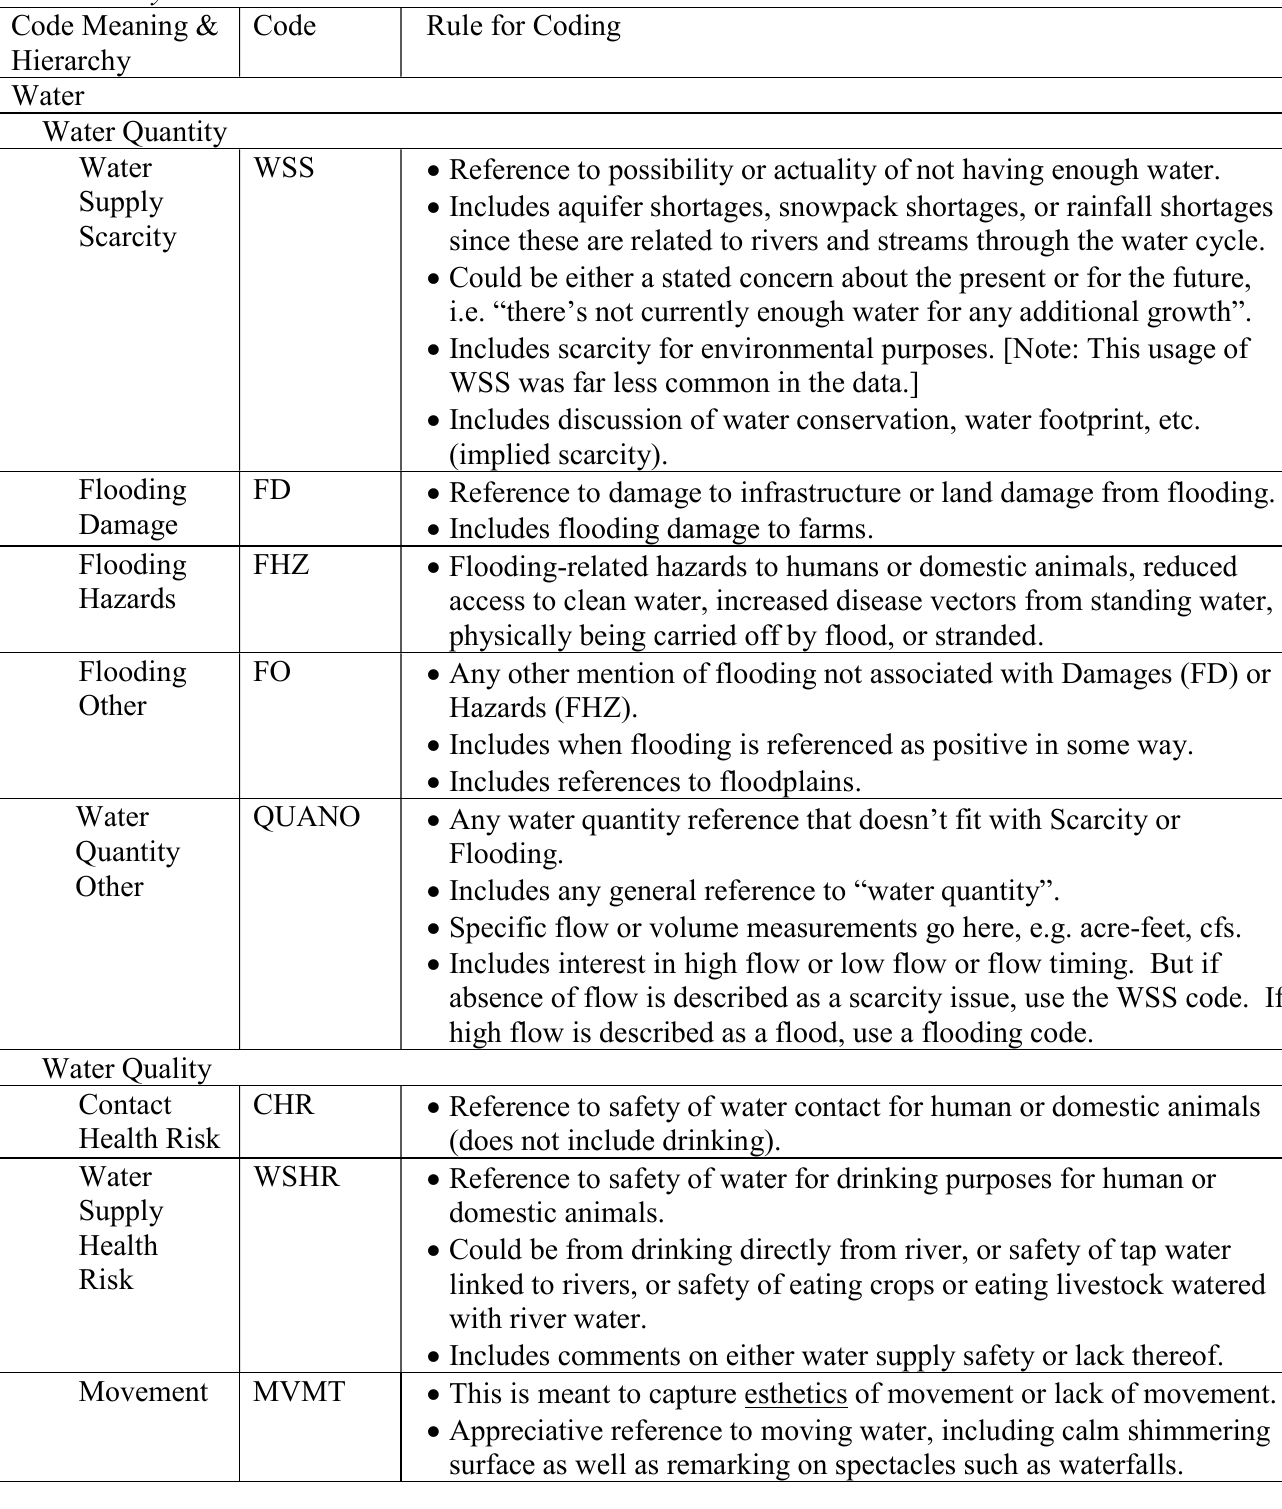
Appendix 1 : Codebook hierarchy, code shorthand, and coding